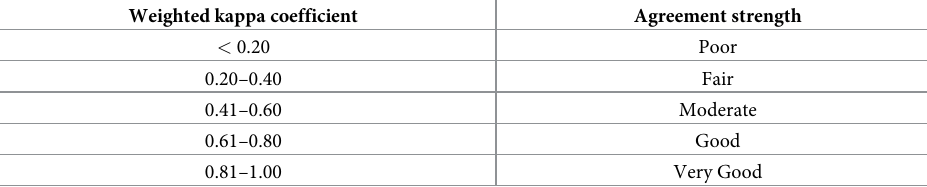
Table 3. Agreement strength according to the weighted kappa coefficient